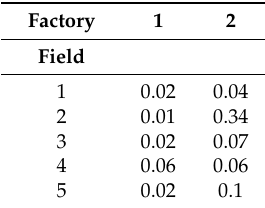
Table 9. Probability of bomb occurring between fields and collecting